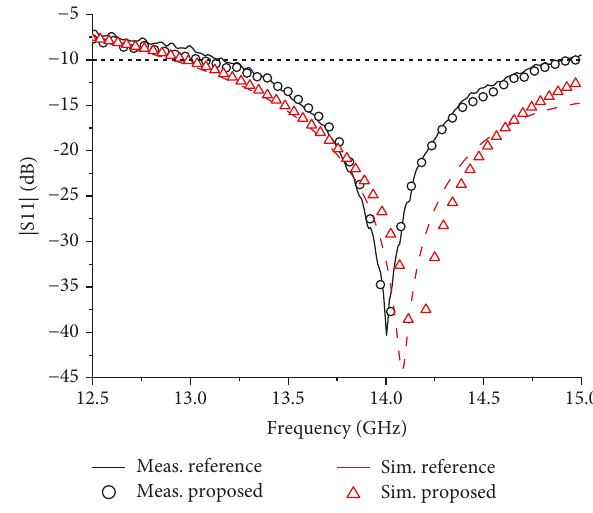
Figure 10: Measured and simulated |S11| of the